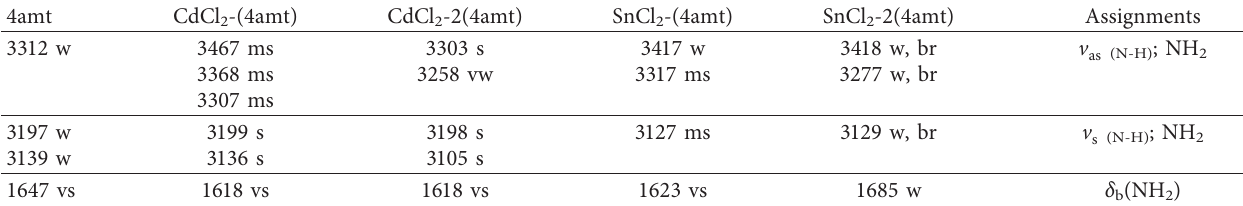
Table 3: Major infrared bands (cm − 1 ) for 4amt and its Cd(II) and Sn(II)